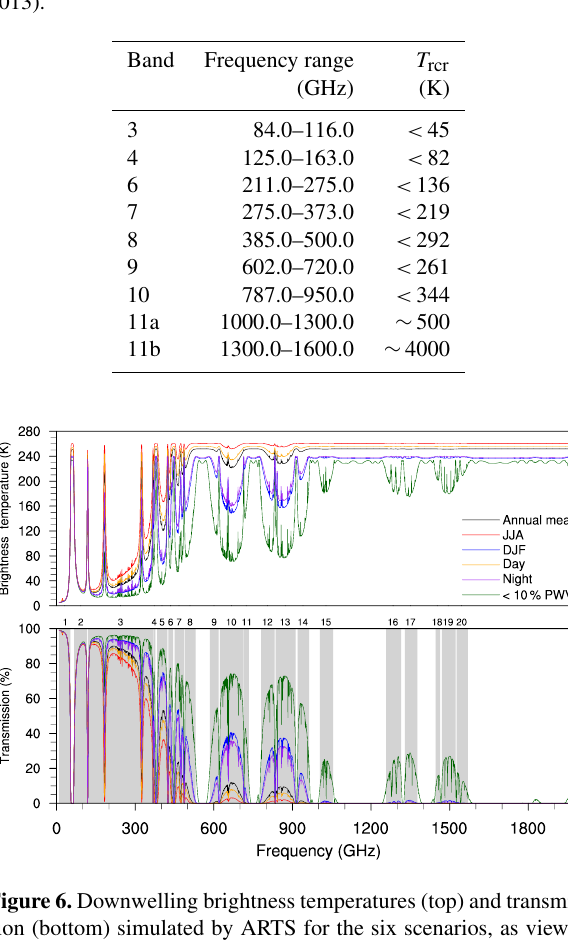
Table 4. Receiver noise temperatures for ALMA bands. Bands 3-10 are taken from Table 4.1 of Remijan (2015) and show the T rcr for any frequency in the range (the upper limit). Band 11 specifications are based on preparatory work by Masao Saito (Rigopoulou et al., 2013).